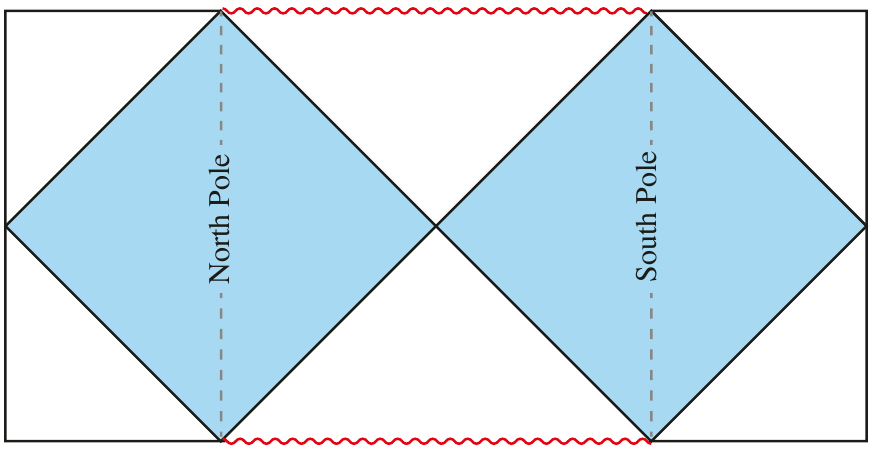
Figure 6 . The Schwarzschild-de Sitter causal diagram showing the shared exterior, as well as a shared black hole interior, between two (previously) antipodal observers. As the black hole is removed the interior geometry of the black hole is replaced with a de Sitter exterior